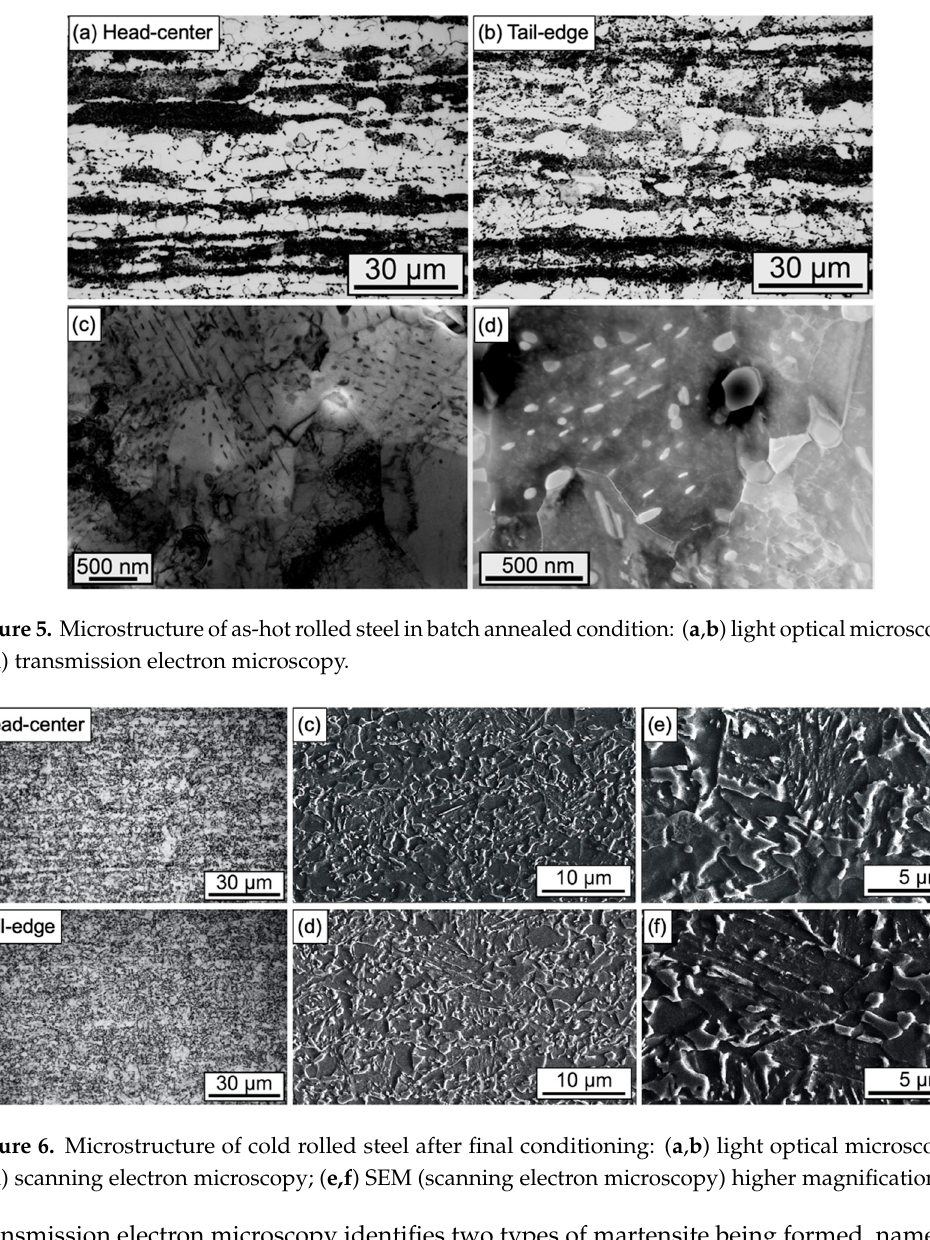
Figure 7. Identification of microstructural details after final conditioning by TEM: ( a ) co-existence of lath (L) and twinned (T) martensite; ( b ) geometrically necessary dislocations (GND) at boundary between ferrite and martensite; ( c,e ) twinned martensite; ( d,f ) lath martensite.